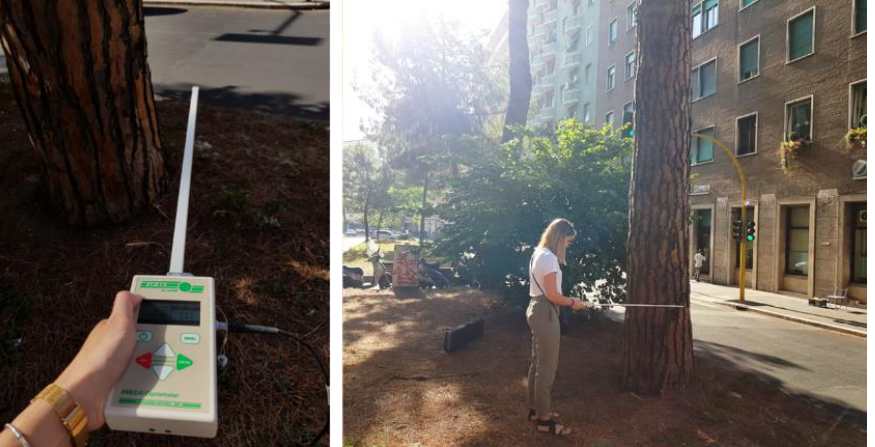
Figure 7. ( Left ): AccuPar LP-80 ceptometer. ( Right ): LAI measurements performed during the campaign. the campaign.